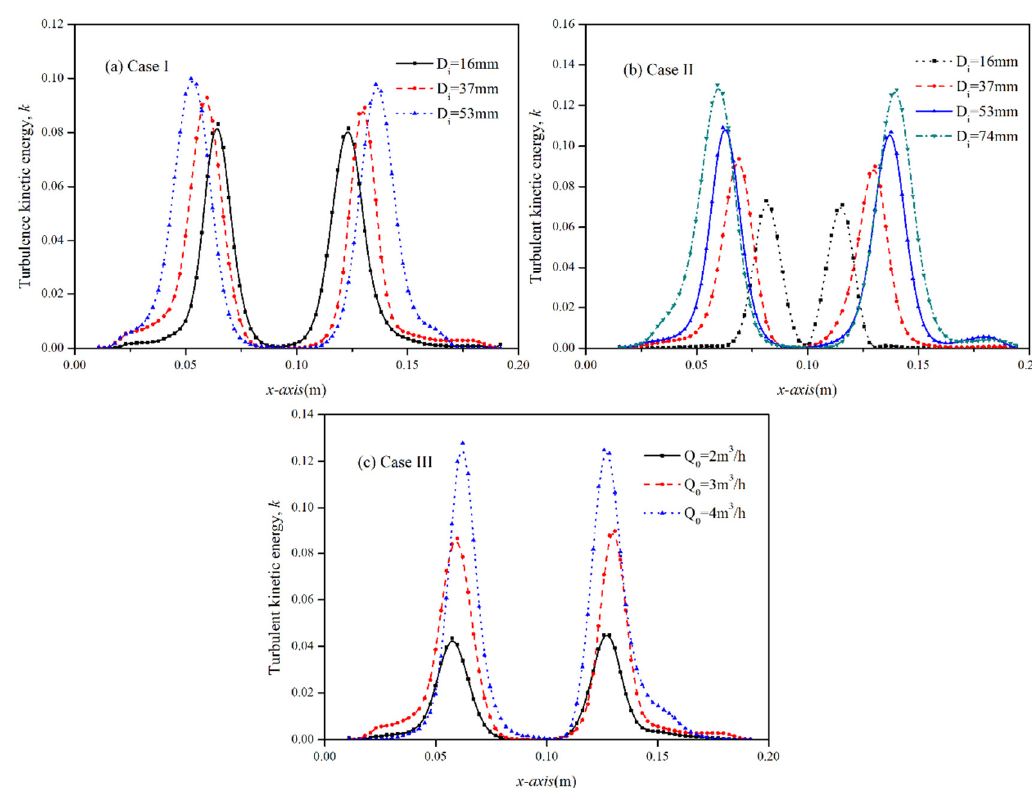
Figure 9. The turbulent kinetic energy (κ) along the centerline under three cases.